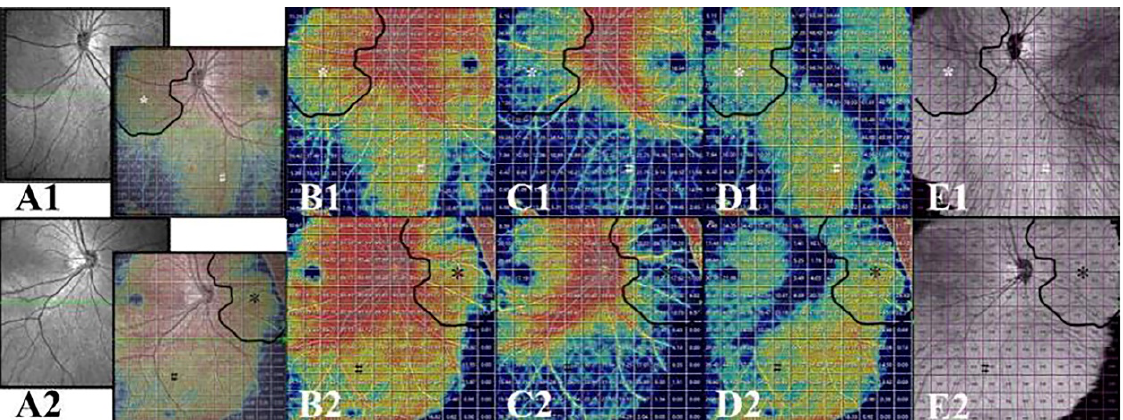
Figure 5. Quantification of all lesion areas and corresponding normal areas in both eyes. ( A1 – E1 ) Images of one eye with a DWOP lesion. The DWOP lesion was manually delineated based on en-face OCT images (shown as a black curve). VD ( B1 – D1 ) and CVI values ( E1 ) presented in 1 mm × 1 mm grids were used in the statistical analysis. The white * represents the site of the DWOP lesion, the white # represents the normal area. ( A2 – E2 ) Images of the compared eye without a DWOP lesion. The black curve was obtained by horizontally flipping the black curve in ( A1 – E1 ) to the corresponding position. VD ( B2 – D2 ) and CVI values ( E2 ) presented in 1 mm × 1 mm grids were used in the statistical analysis. The black * was used for matching analysis with the DWOP lesion (white *) in ( A1 – E1 ). The black # was used for matching analysis with the normal area (white #) in ( A1 – E1 ). DWOP, dark without pressure; OCT, optical coherence tomography; VD, vessel density; CVI, choroidal vascularity index.